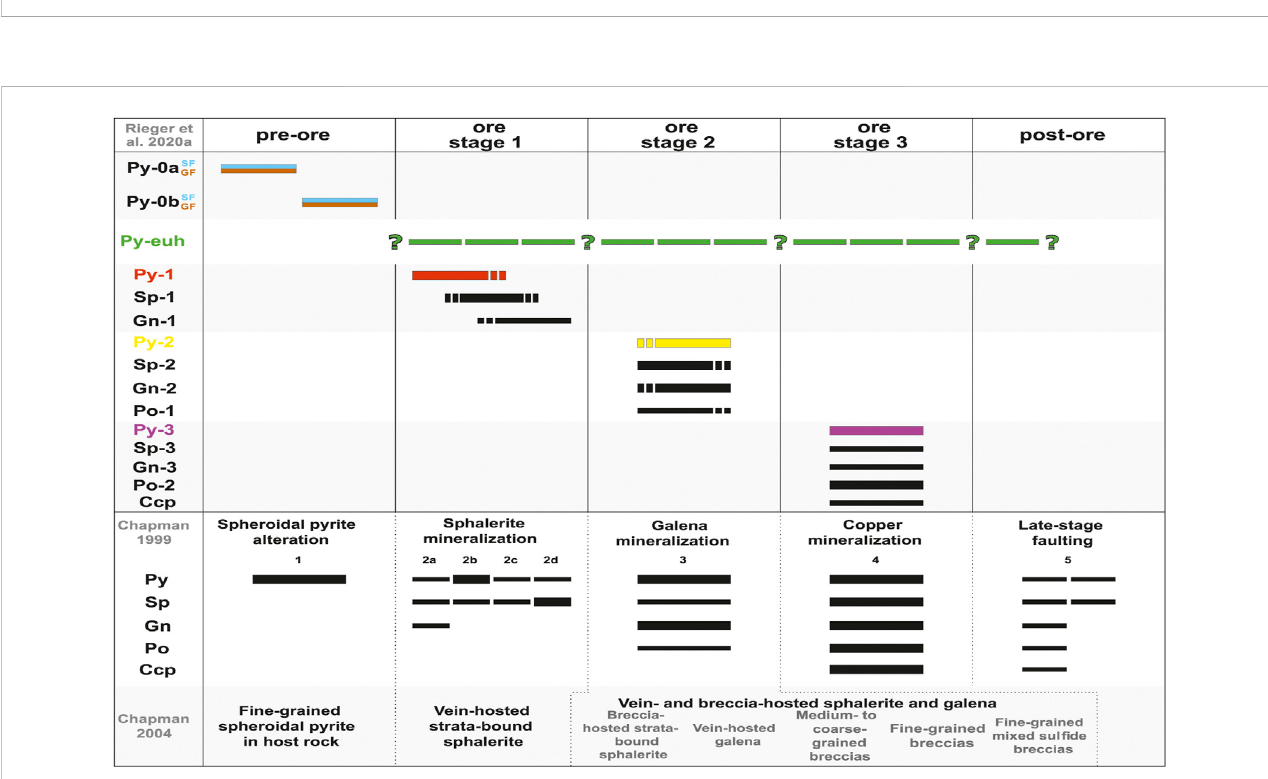
The paragenetic sequence of sul fi de minerals at the George Fisher deposit as determined by Chapman (1999, 2004) and Rieger et al. (2020a); modi fi ed after Rieger et al., 2020a). The individual bars show the relative timing of sul fi des and bar thickness denotes the abundance within respective sul fi de stages. Mineral abbreviations are: chalcopyrite (Ccp), galena (Gn), pyrrhotite (Po), pyrite (Py), and sphalerite